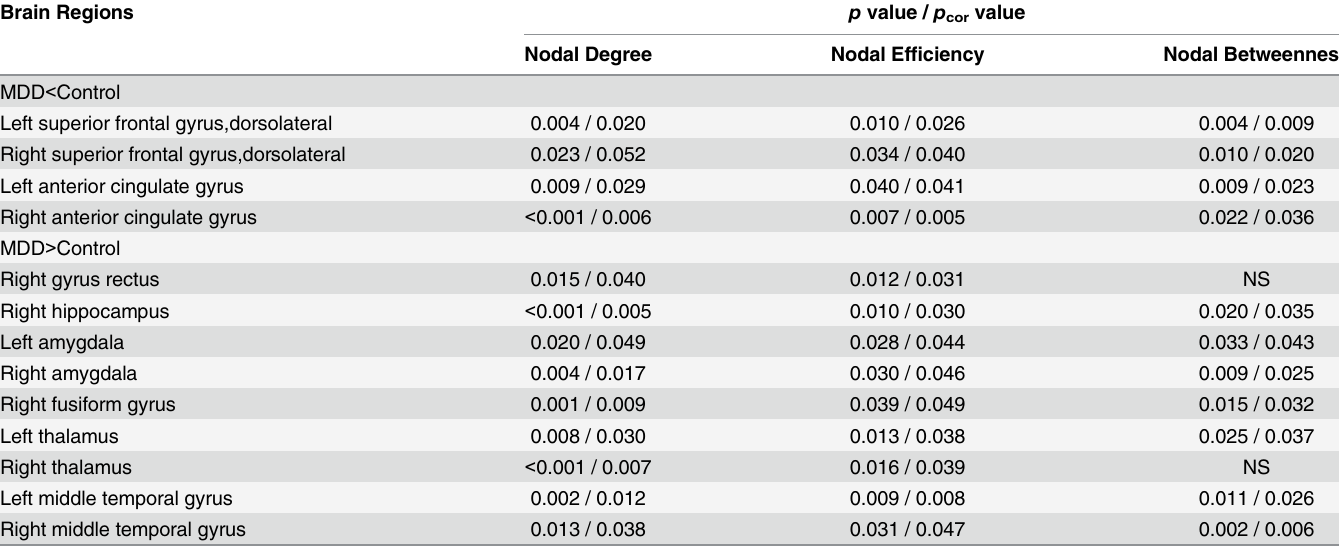
Table 2. Regions showing disrupted nodal centralities in MDD patients as compared with healthy controls (cost =